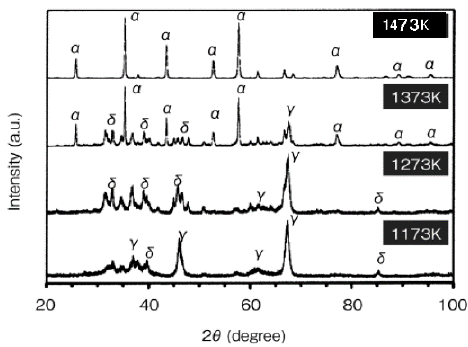
Figure 25. Change of density as a function of temperature at 690 MPa.